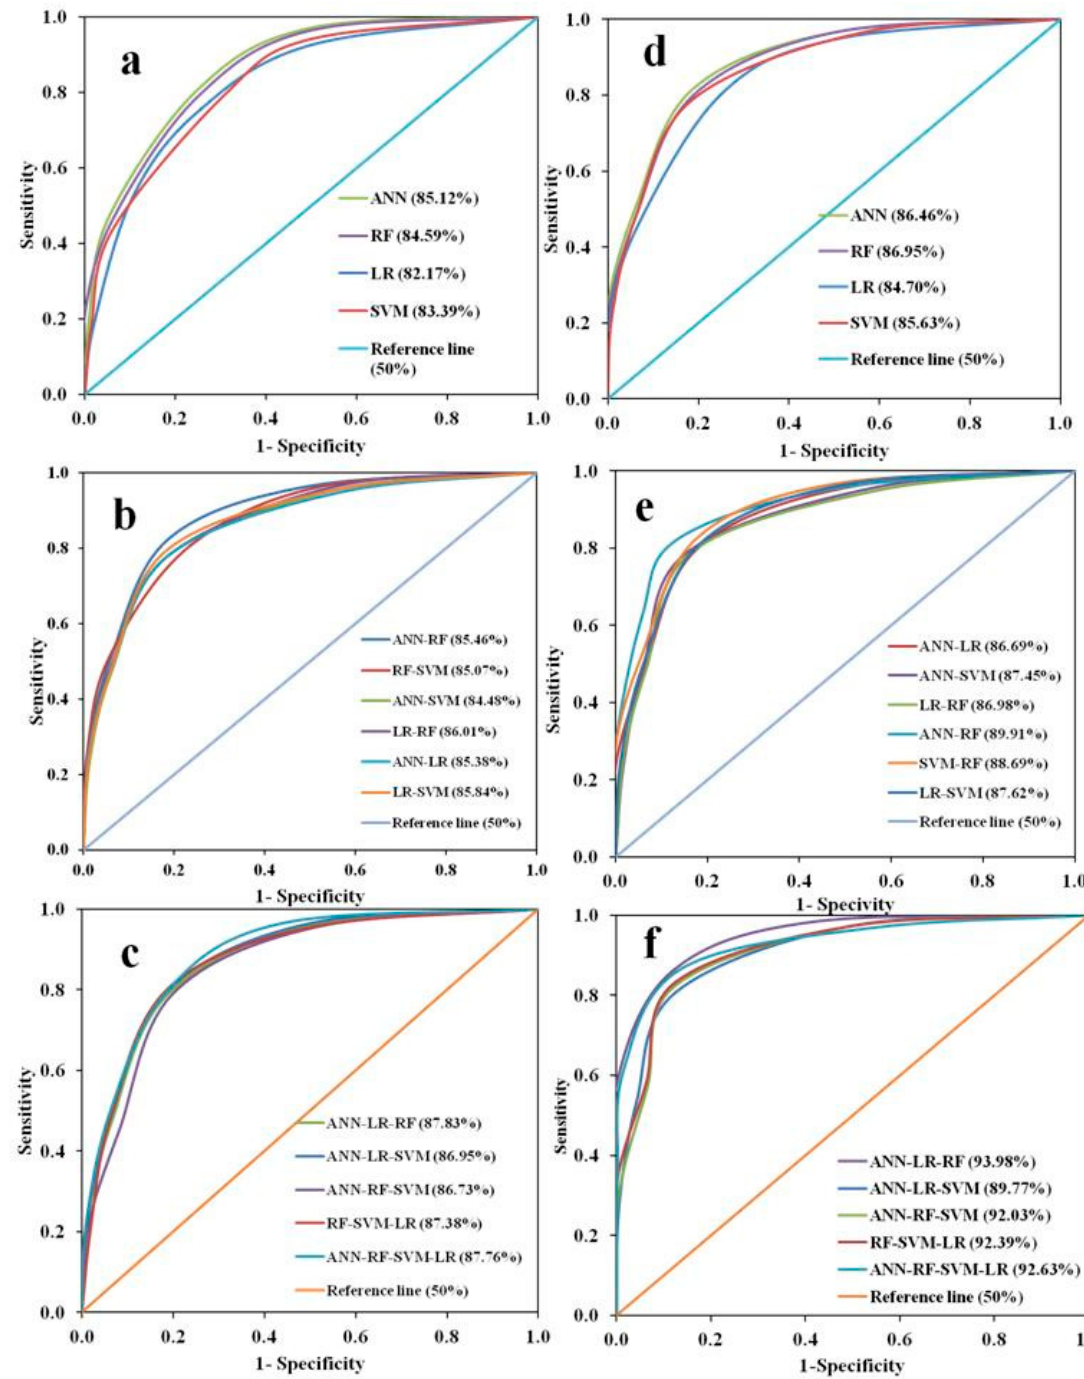
Figure 10. Area under the curves based on training datasets (success rate curve): ( a ) individual models, ( b ) ensemble of two models, and ( c ) ensemble of three or four ensemble models; based on validation datasets (prediction rate curve): ( d ) individual models, ( e ) ensemble of two models, and ( f ) ensemble of three or four ensemble models.